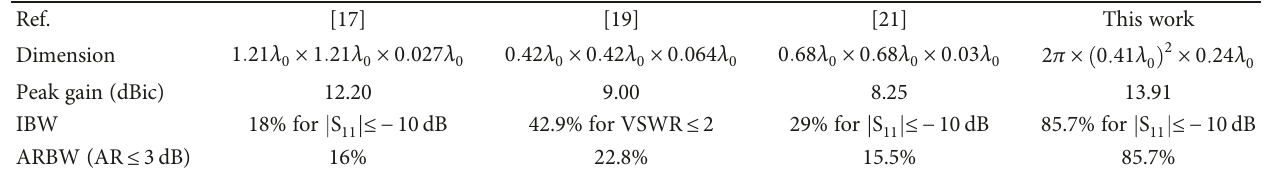
Table 2: Performance summary of published 2 × 2 arrays and the proposed work.